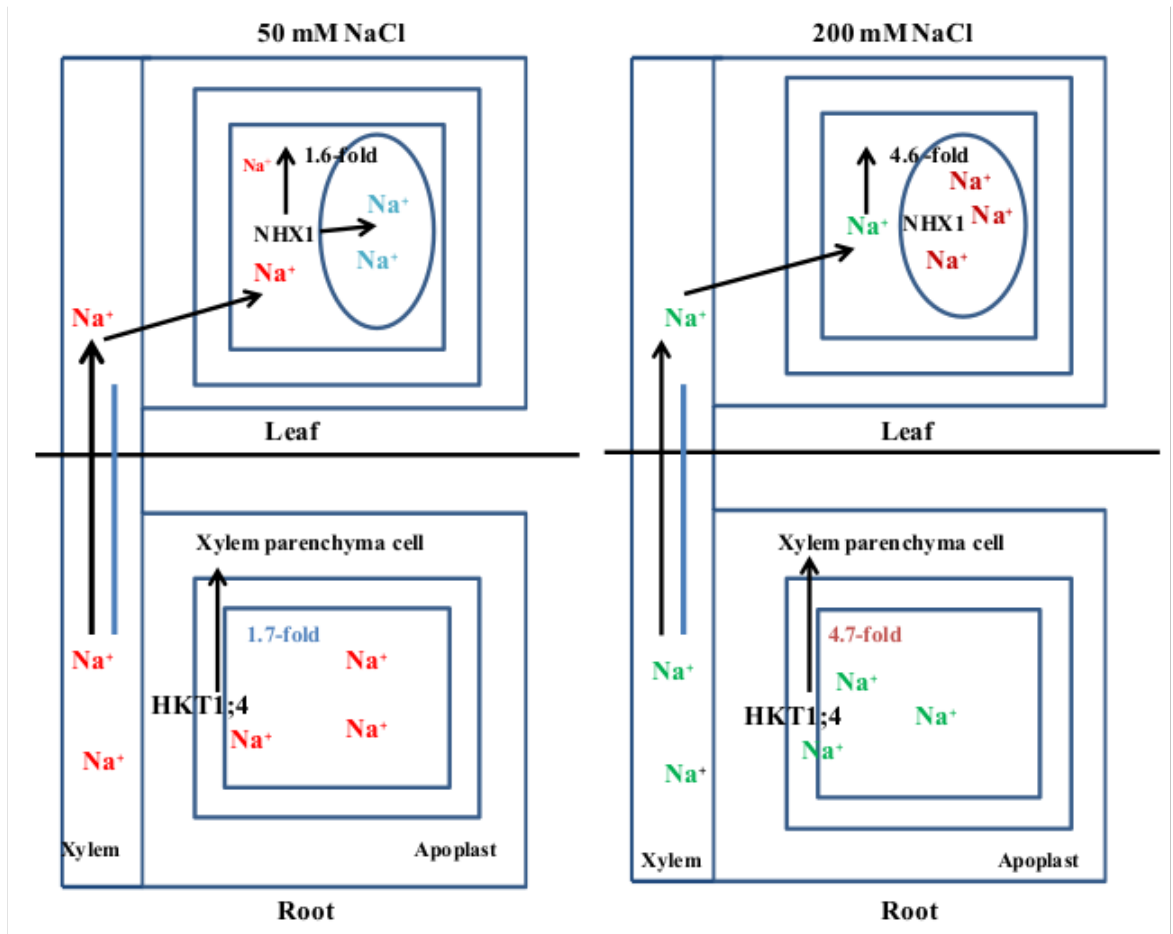
Figure 7. The schematic model of AeHKT1;4 and AeNHX1 in Na + transport under salinity stress conditions in Ae. tauschii . Under lower salinity stress conditions (50 mM NaCl), AtNHX1 in leaves compartmentalized of Na + in vacuoles and sequestering Na + would increase loading into xylem by AeHKT1;4 . Na + could transport in leaves by the transportation stream; under high salinity stress conditions (200 mM NaCl), Na + rapidly and unremittingly sequesters in vacuoles of leaves by AeNHX1 . The vacuoles’ capacity becomes saturated by sequestering Na + , which restricted the Na + transport from roots and induced the expression level of AeHKT:4 and assisted in the unloading of excessive Na + from the